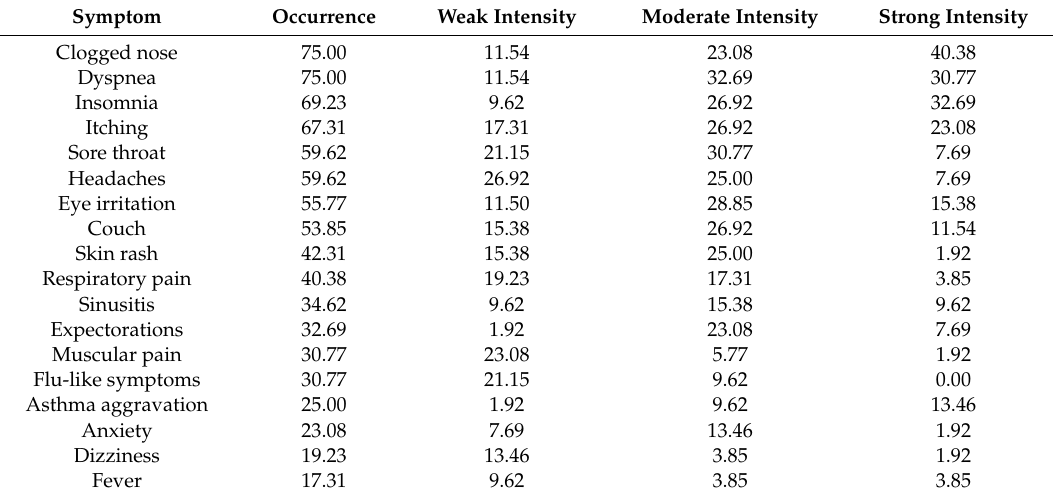
Table 4. Symptoms occurrences (%) and intensities (weak / moderate / strong) in mold-damaged homes. Symptom Occurrence Weak